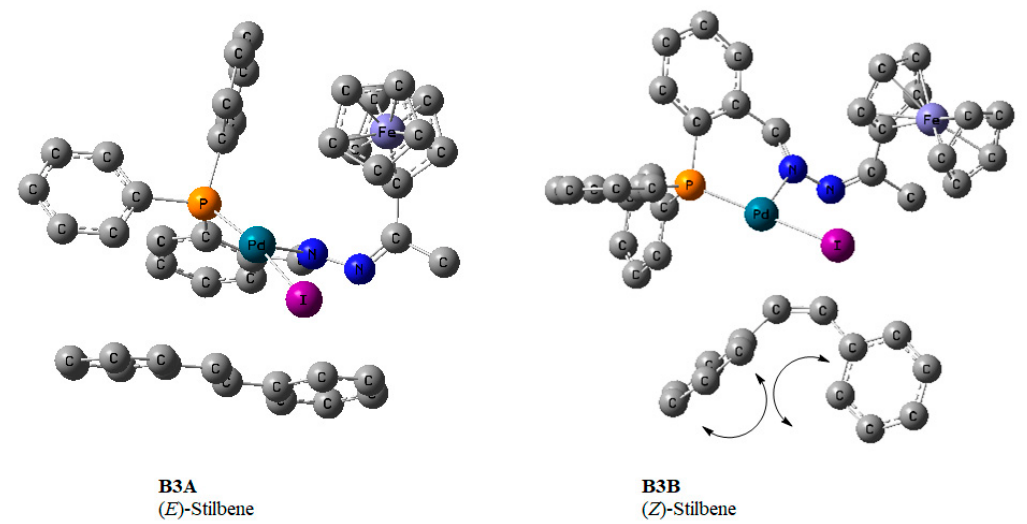
Figure 20. DFT/MO6 optimized geometries of B3A and B3B showing the E ‐ and Z ‐ stilbene scenarios, respectively. Hydrogen atoms omitted for clarity. The hydrogen atoms have been removed; this includes the one coordinated directly to the Pd centre.